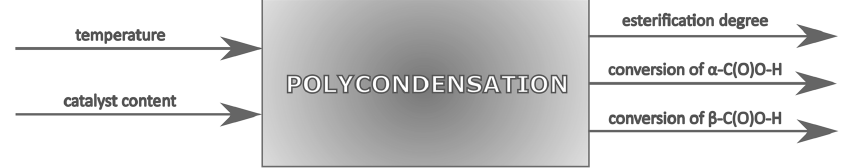
Figure 5. “Black box” for the optimized process.